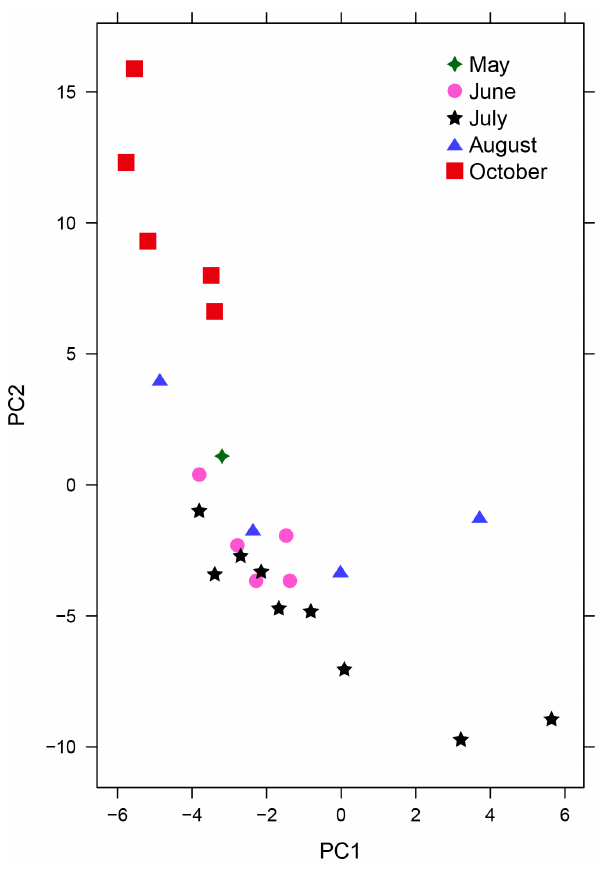
Table arranged by peak appearance in a given sample group. The number of samples within a month group in which each peak appears is indicated in the last column. Retention time was rounded to the nearest 0.1 min. Mass accuracy was 5–10 ppm. Rt=retention time.